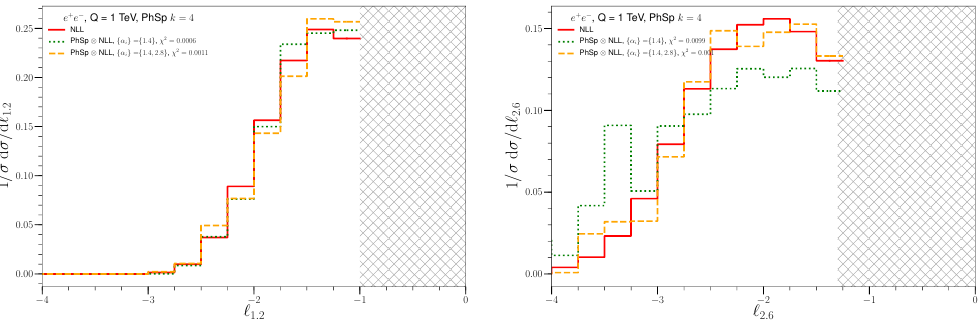
Figure 13 . Same as (cid:12)gure 6, but with the reweighing performed using the multi-dimensional analytical distributions calculated directly (rather than projections from a single multi-dimensional